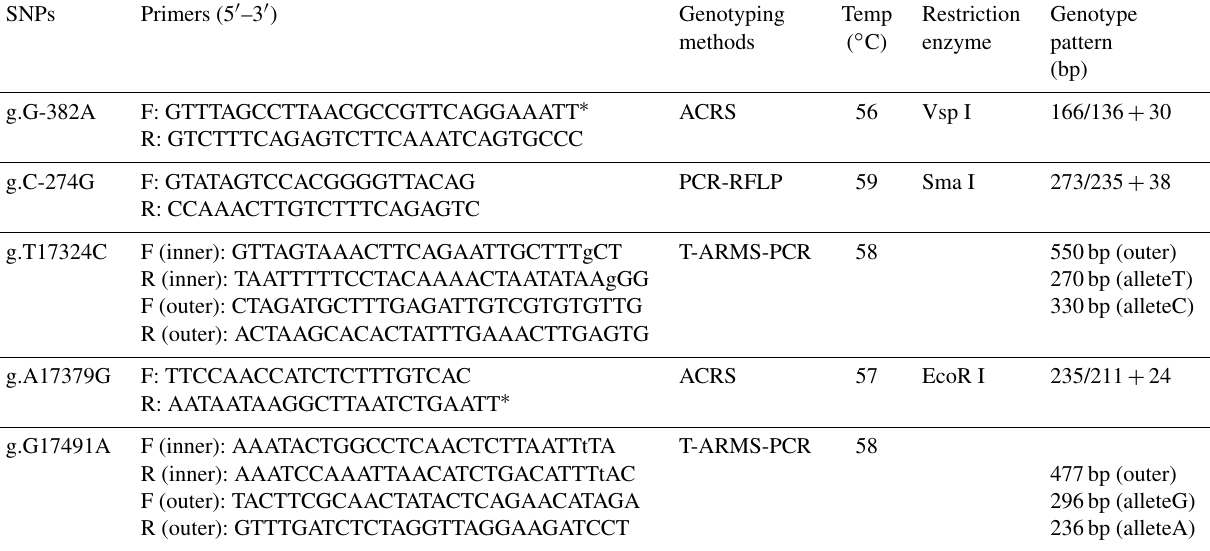
Table 1. PCR primers and conditions for identification of SNPs in SIRT1 (NM_001192980). SNPs Primers (5 (cid:48) –3 (cid:48) ) Genotyping Restriction Genotype